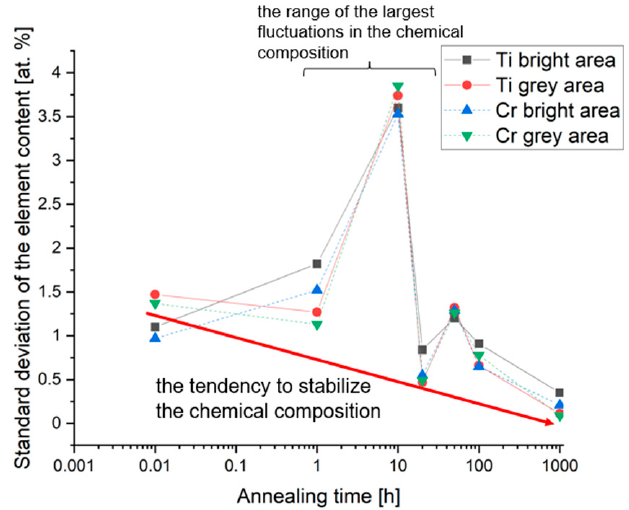
Figure 8. Nonmonotonic change in the stabilization tendency of the chromium and titanium chemical composition in the areas of the two-phase, ultra-fine-grained matrix of the TiCoCrFeMn sinter, observed in the area of 10 h of homogenization at 1000 ◦